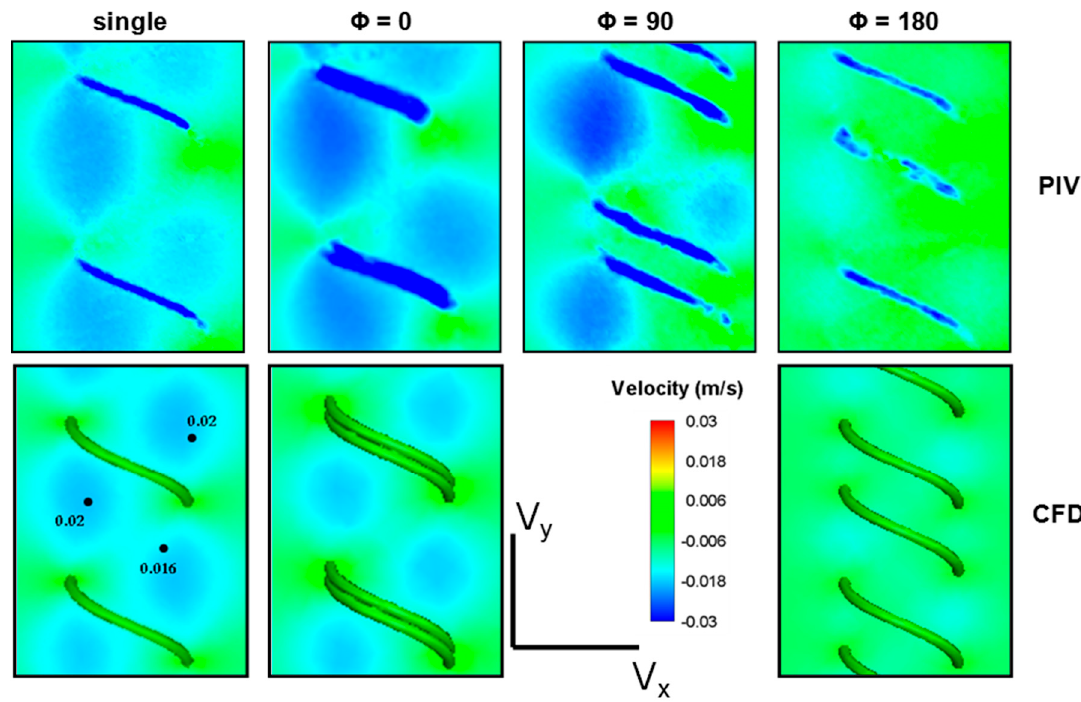
Figure 5. The axial velocity component, V y in the center plane acquired using PIV measurements (top row) and CFD simulations (bottom row). Compared to the single flagellum, a slight increase is observed for the in-phase ( Φ = 0) double flagella configuration. In comparison, the two out-of-phase ( Φ = 90 and Φ = 180) double flagella configurations demonstrated a decrease in V y affecting the thrust production.